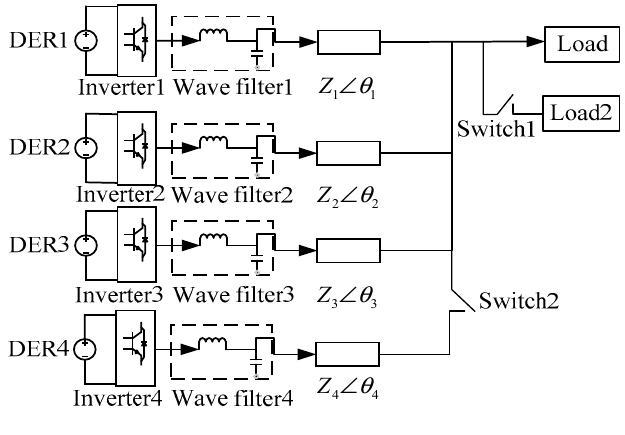
Figure 5. Microgrid system.